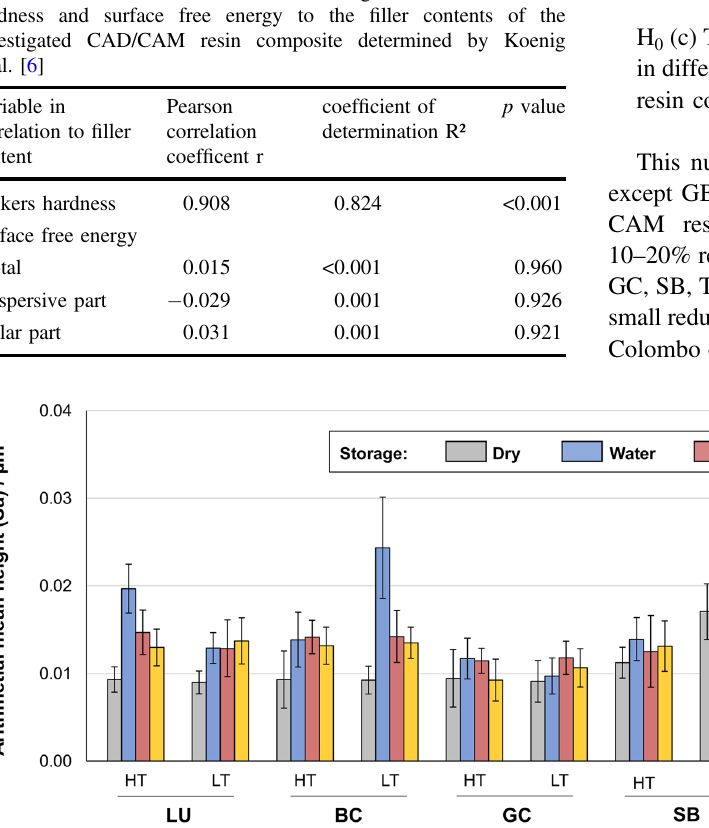
Fig. 3 Sa (arithmetical mean height) as a description for surface roughness (mean and standard deviation) and as a function for the respective storage: dry for 24 h; water, cola and ethanol for 28